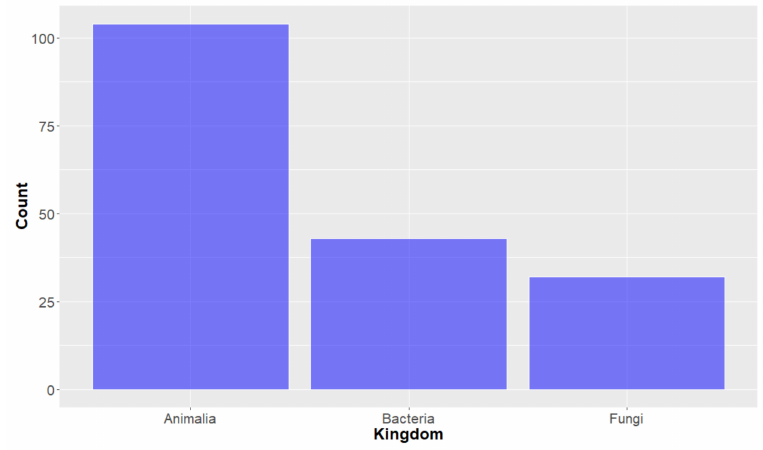
Figure 2. Number of natural products isolated from deep-sea marine organisms, by Kingdom.